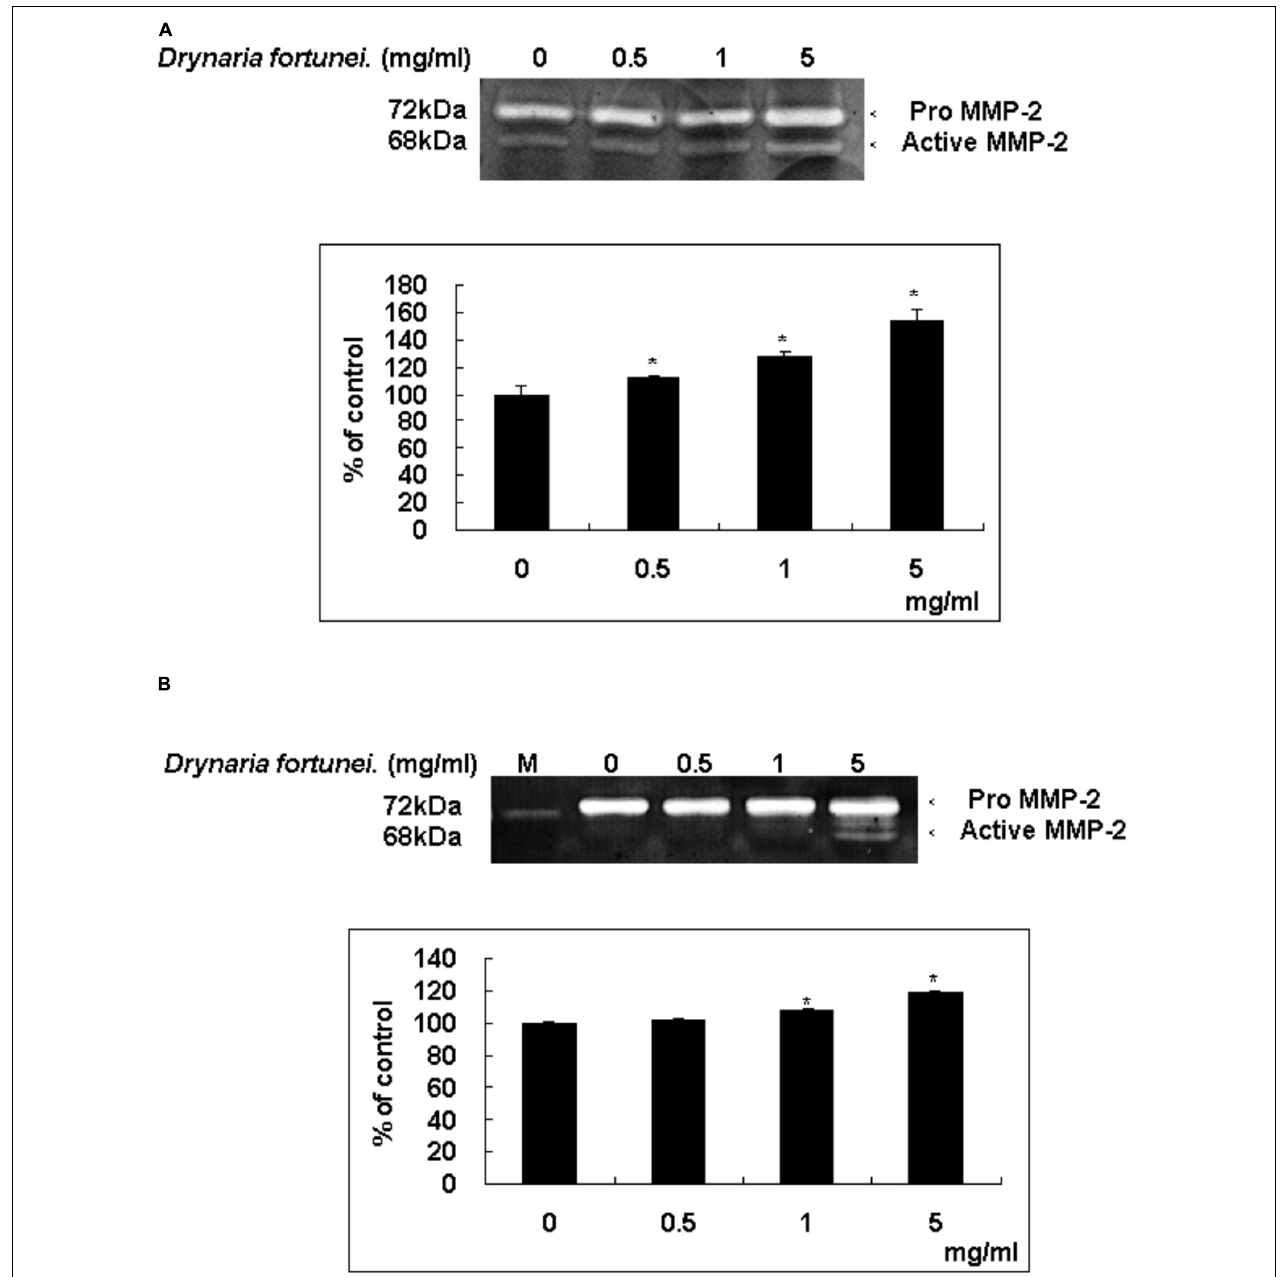
FIGURE 5 | D. fortunei activated the MMP-2 activity both in vivo and in vitro . The effect of MMP-2 activity with the treatment of D. fortunei was determined by gelatin zymography. The conditioned media were collected from (A) CAM of 10-day-old chick embryos and (B) HUVEC cells with different concentrations of D. fortunei for 24 h. White bands on blue backgrounds indicated zones of digestion corresponding to the presence of MMP-2. The active MMP-2 with densitometry analysis was enhanced associated with the increasing concentrations of D. fortunei both in vivo and in vitro . Data were mean ± SD calculated from three individual experiments. An asterisk demonstrated the significant difference ( ∗ P < 0.05) compared with control. M indicated medium only without